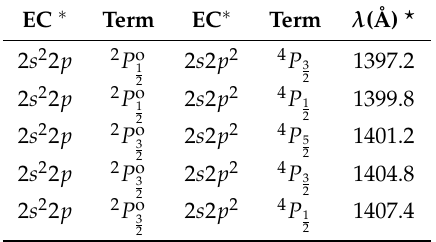
Table 3. O IV ] λ 1402 line identification.